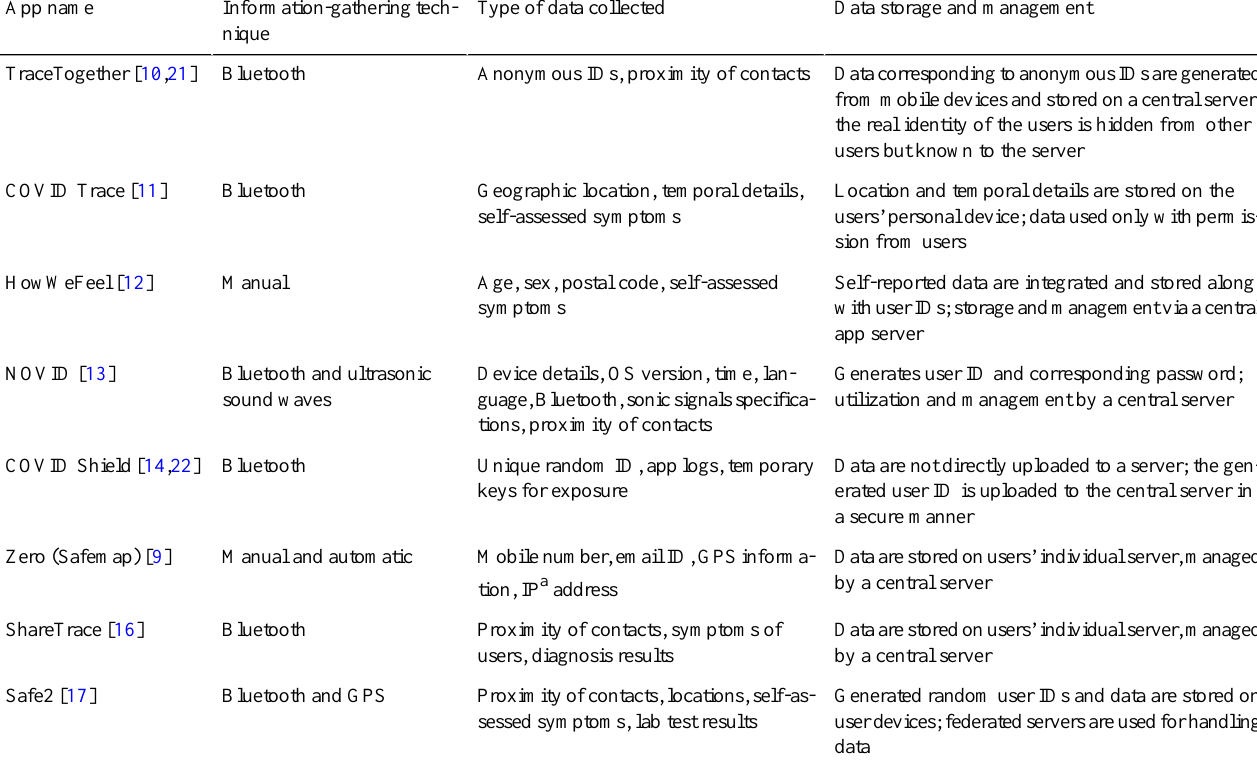
Table 1. Existing contact tracing techniques for